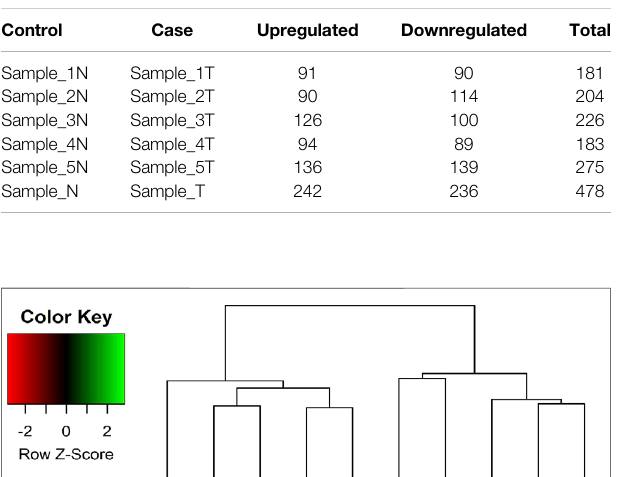
TABLE 2 | Number of DE circRNAs in different samples.